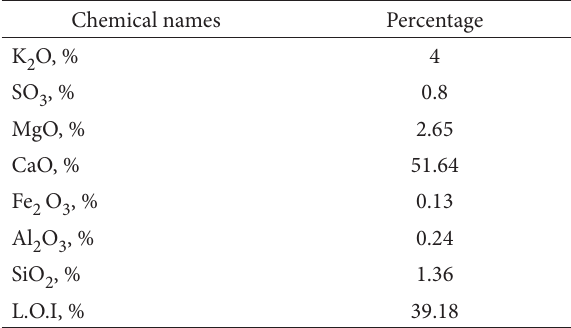
Table 2. Results of chemical analysis of the Lime